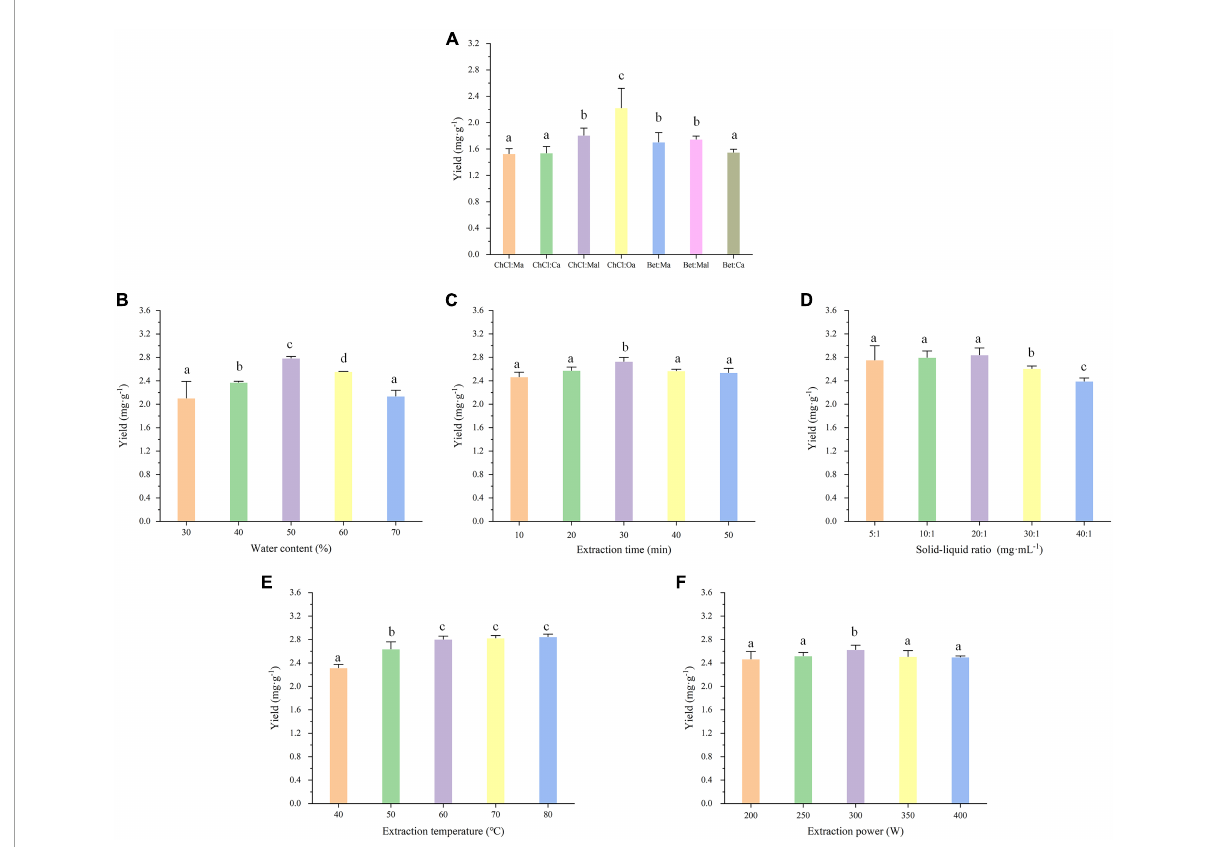
FIGURE2 Effects of different natural deep eutectic solvents (NADES) types (A) , water content (B) , extraction time (C) , solid-liquid ratio (D) , extraction temperature (E) , and extraction power (F) on extraction yield of ellagic acid (EA) from Geum japonicum (GJ). The extraction solvent choline chloride-oxalic acid (ChCl:Oa) was used to investigate the experimental factors panels (B–F) . (Different lowercase letters represent P < 0.05, otherwise P > 0.05, n =